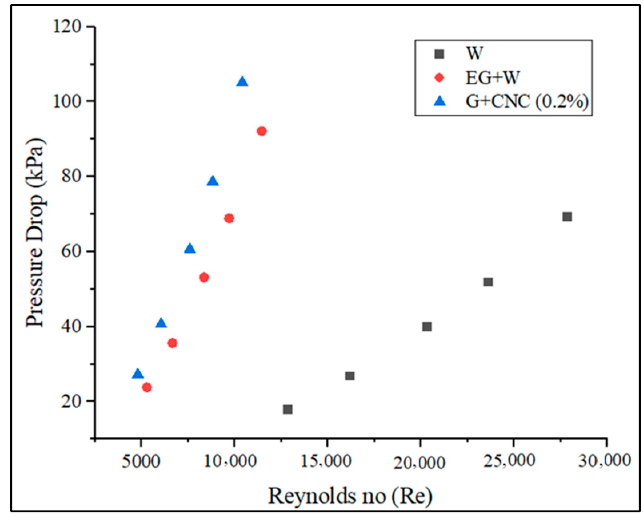
Figure 15. Pressure drop (kPa) vs. Reynolds number (Re).